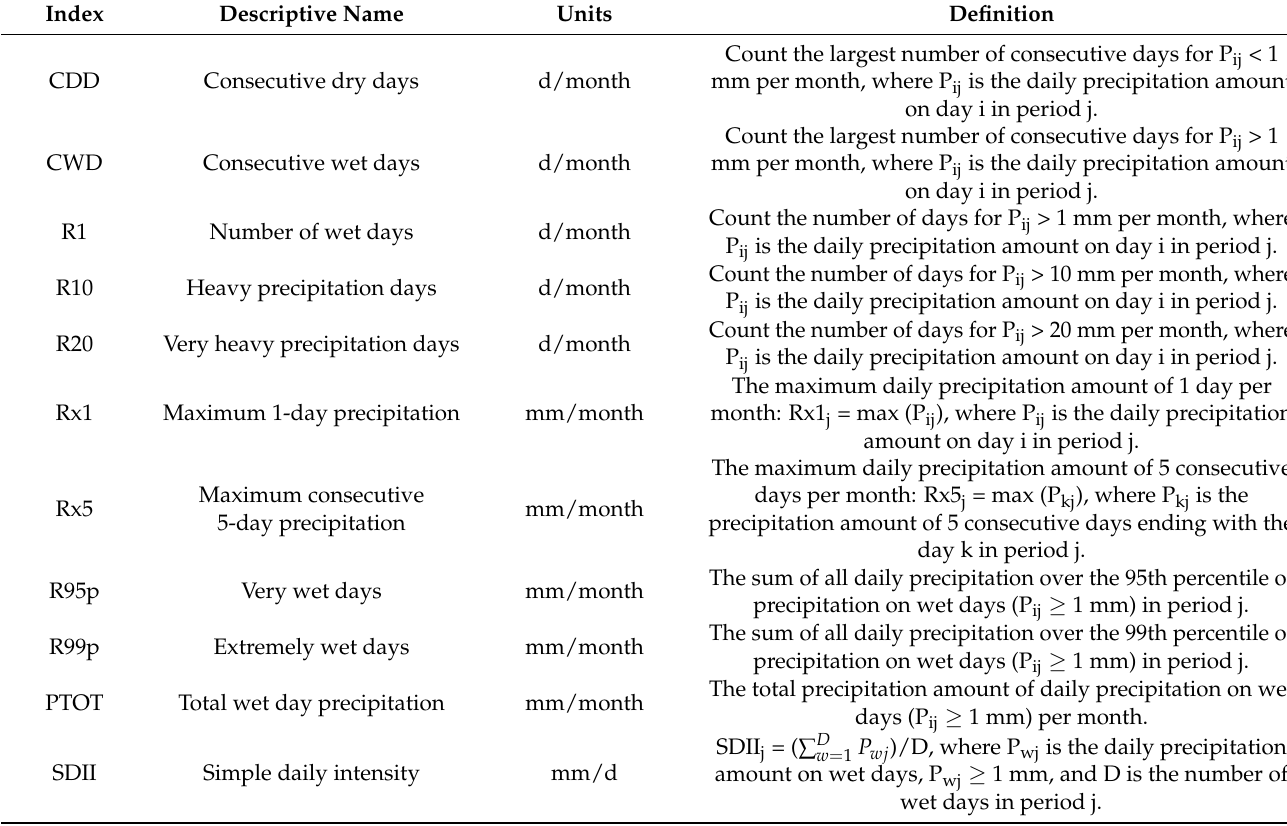
Table 2. List of 11 precipitation indices of the Expert Team on Climate Change Detection and Indices